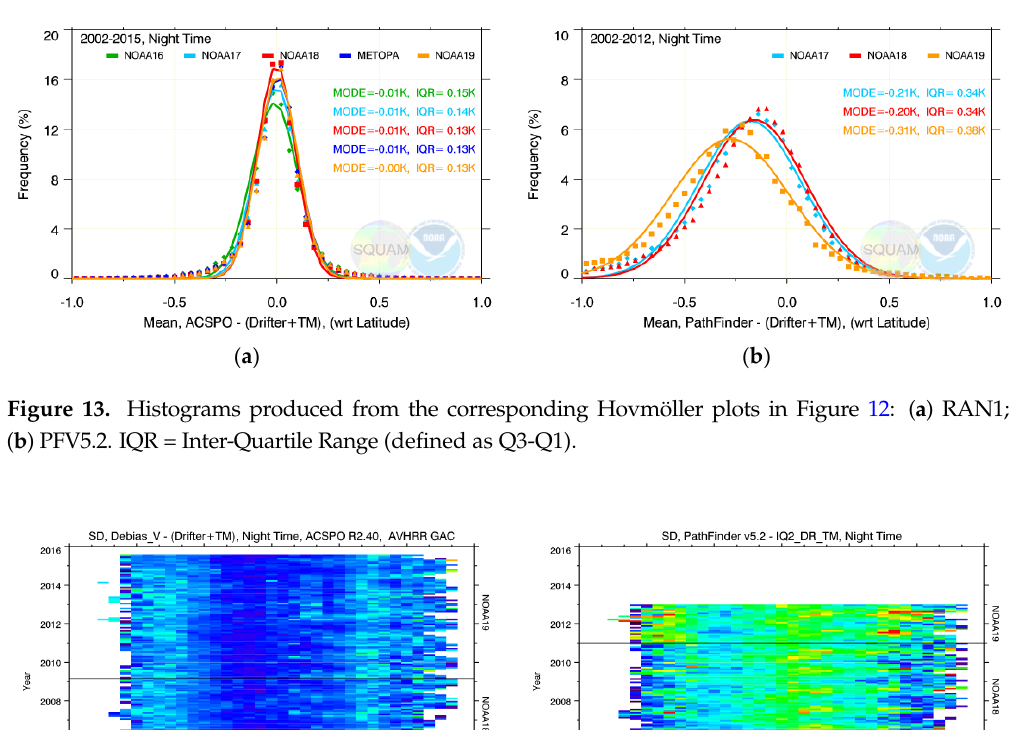
Figure 12. Hovmöller diagrams of mean (over 5 ˝ ˆ month space-time boxes) biases ∆ T S = T S ´ T in situ : ( a ) RAN1 ( b ) PFV5.2.